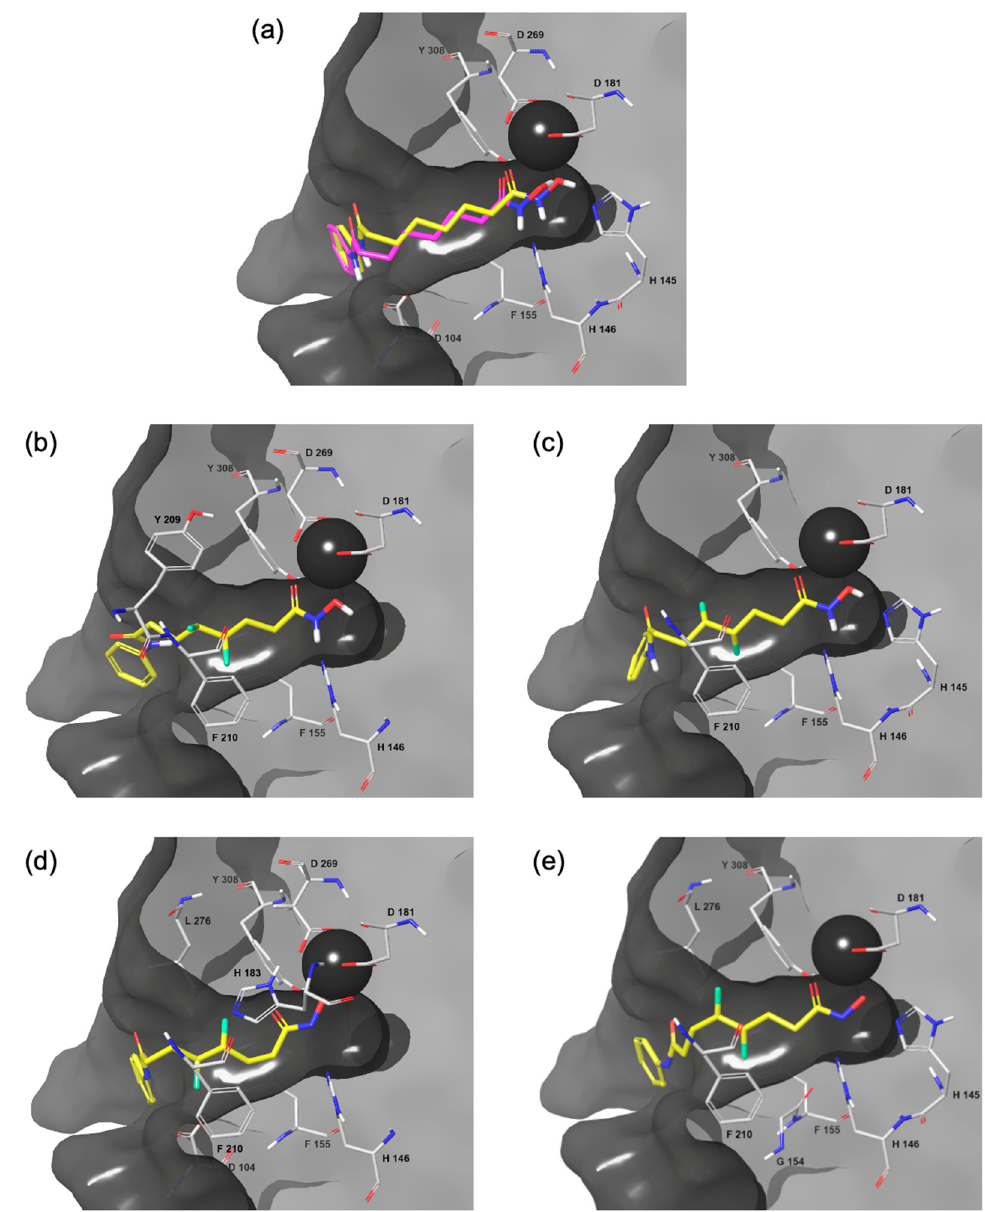
Figure 4. Predicted binding poses of SAHA analogs to HDAC2. Dark grey sphere = zinc ion. ( a ) Ligand 1 (magenta = crystal structure [21]; yellow = docked); ( b ) ligand 2 ; ( c ) ligand 3 ; ( d ) ligand (4 R ,5 S )- 4 ; ( e ) ligand (4 S ,5 R )- 4 .